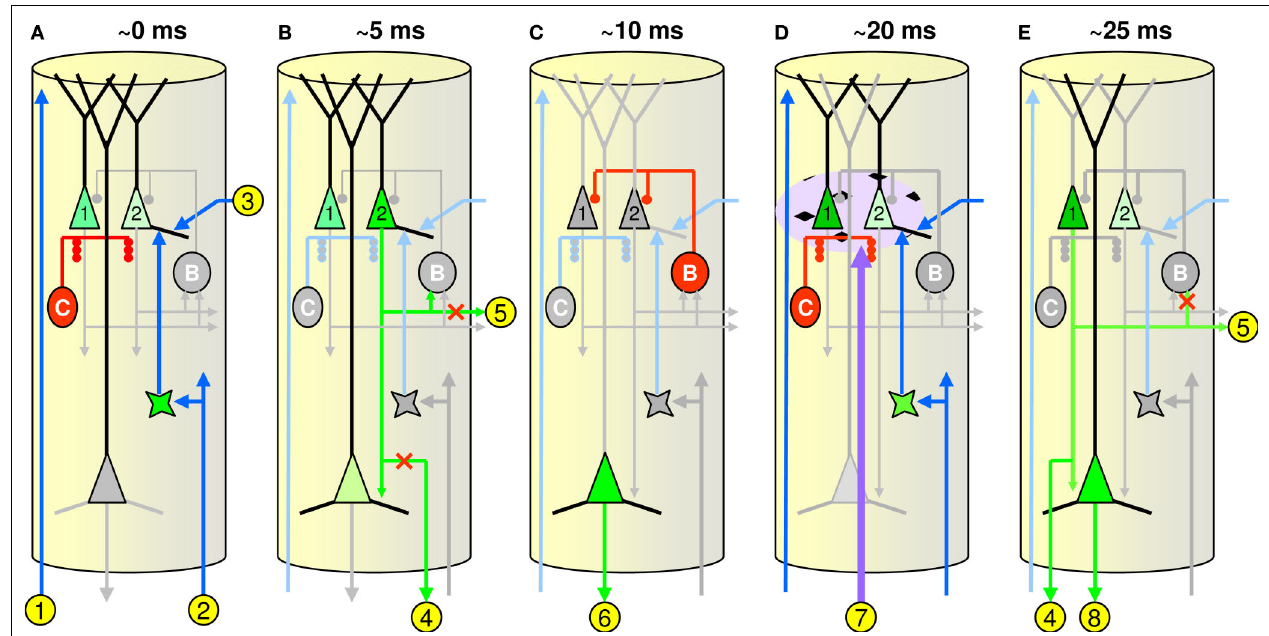
approximate timings relative to start of CSA cycle are shown across top. The units labeled “C” (“B”) represent the local chandelier (basket cell) populations, respectively; See text for detailed